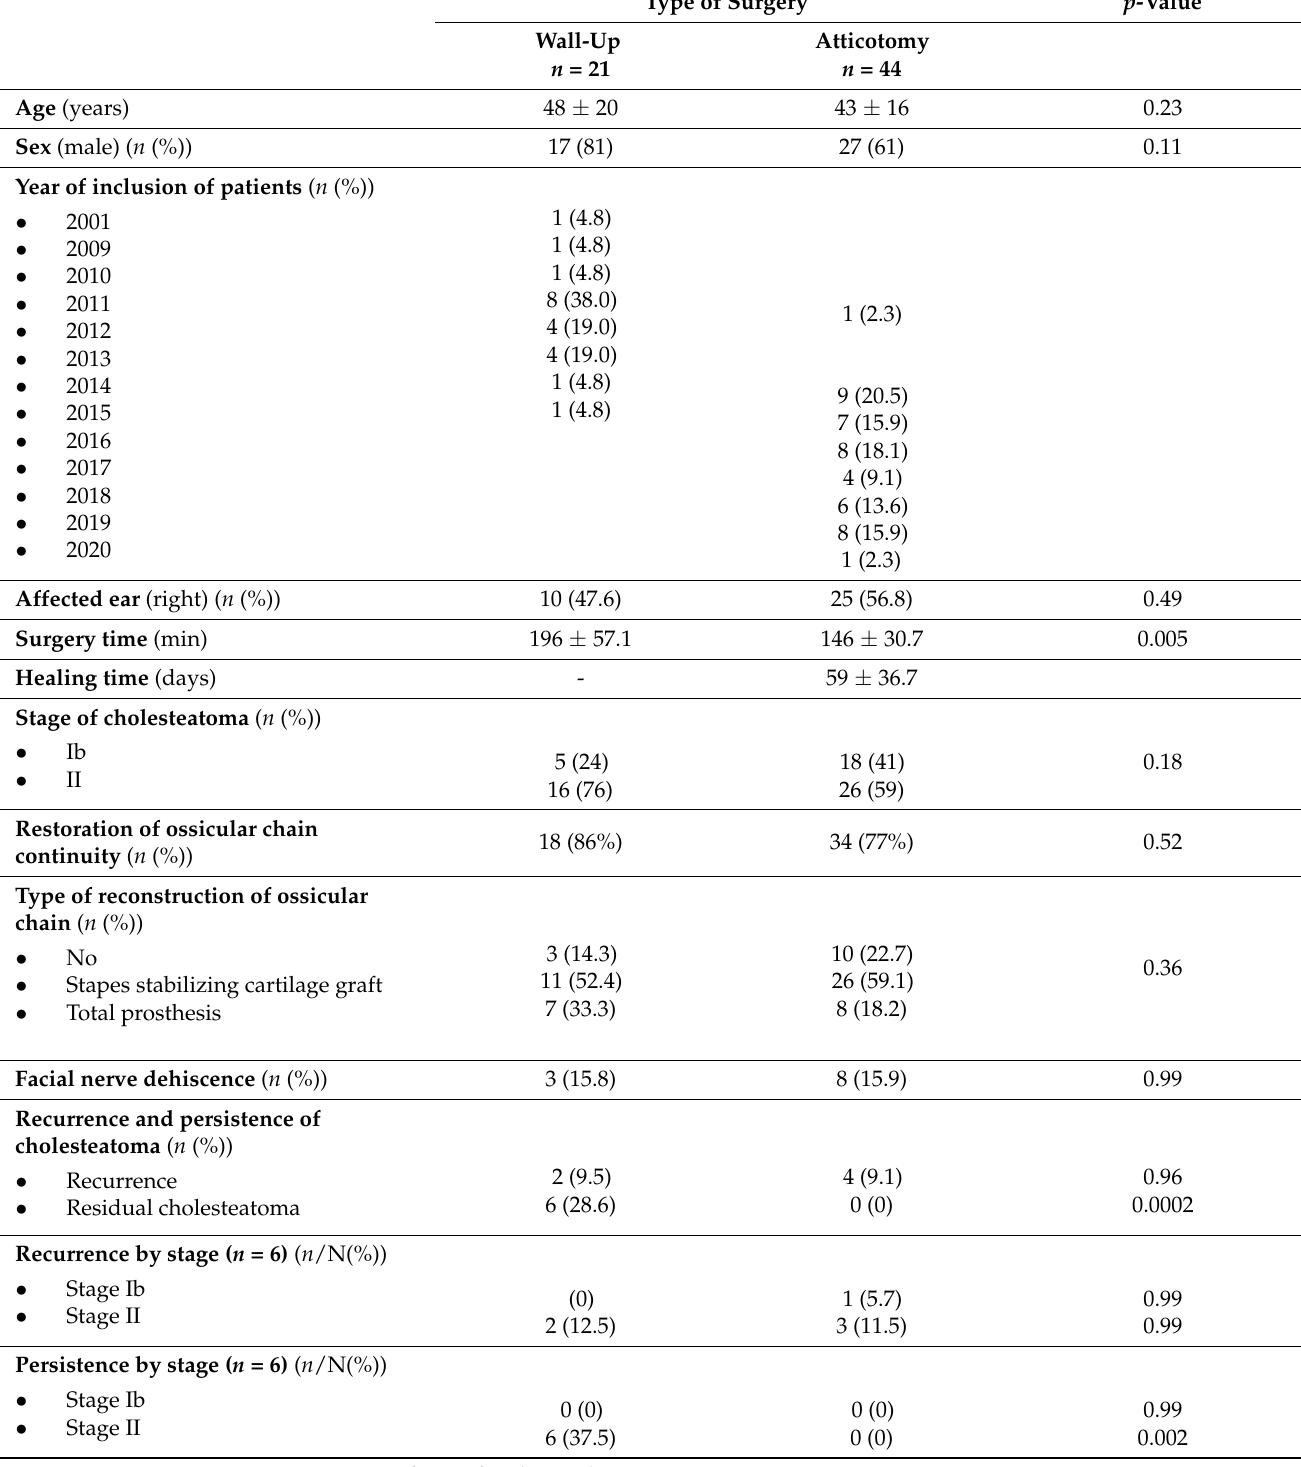
Table 2. Clinical, surgical, and recurrence characteristics according to type of surgery. Type of Surgery p